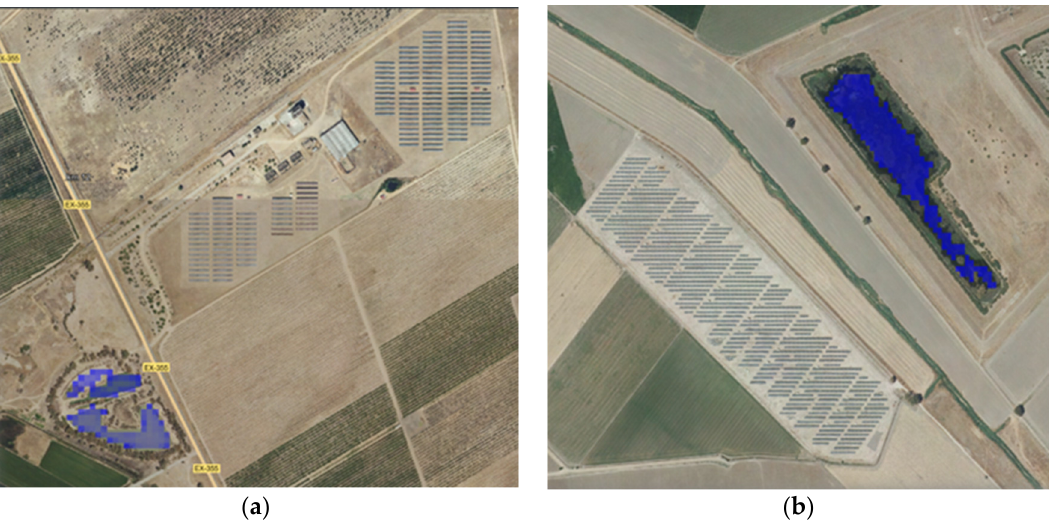
Figure 12. Water ponds detected with the NDWI index in the surroundings of ( a ) plant 1, and ( b ) plant 4.